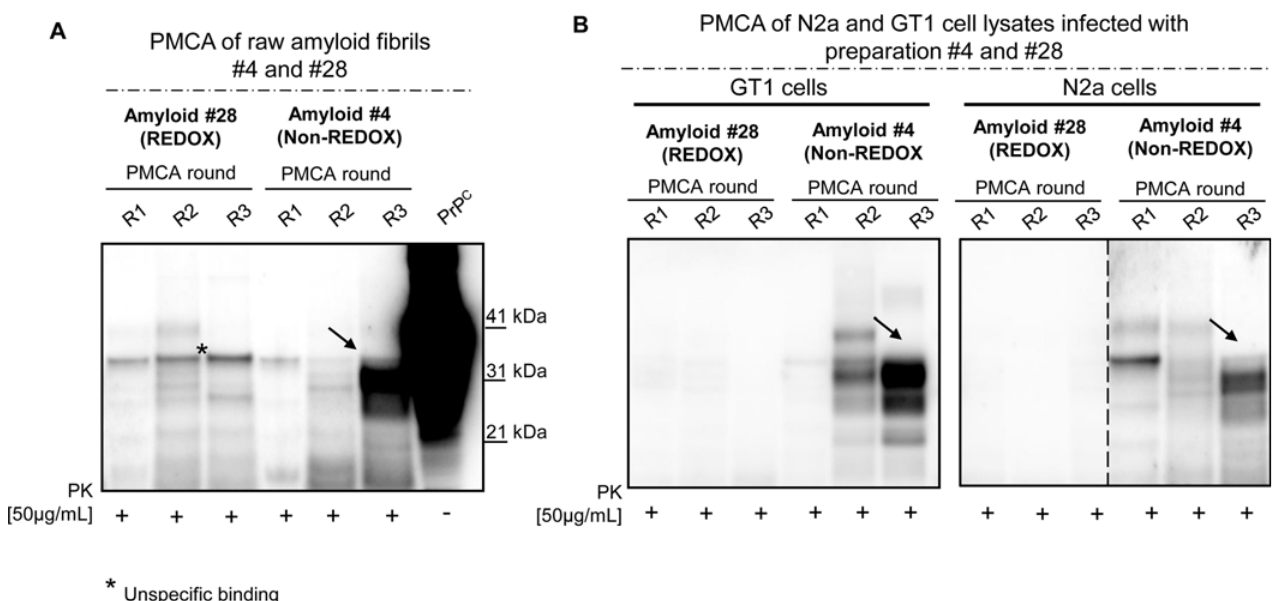
Fig 7. PMCA analysis of raw fibrils and cell lysates from infected N2a and GT1 cell lines. Seeding ability of amyloid #4 and #28 by means of PMCA using brain homogenates of CD1 mice as substrates for amplification (A). PMCA analysis of GT1 and N2a cell lysates (infected with preparations #4 and #28) and collected at passage six (P6) after the infection (B). Black arrow indicates PK-resistant PrP. Asterisk indicates unspecific binding. Western blots were performed using 6D11 monoclonal antibody to PrP (0.2 μ g/mL, Covance). Blots were developed with the enhanced chemiluminescent system (ECL, Amersham Biosciences) and visualized using a G:BOX Chemi Syngene System.